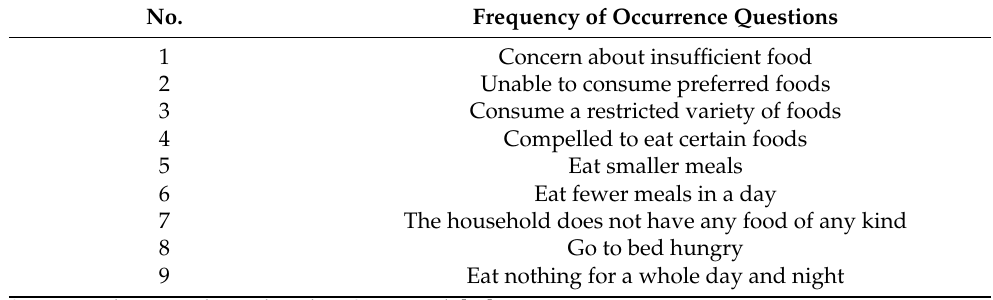
Table 2. The nine “frequency of occurrence” questions.